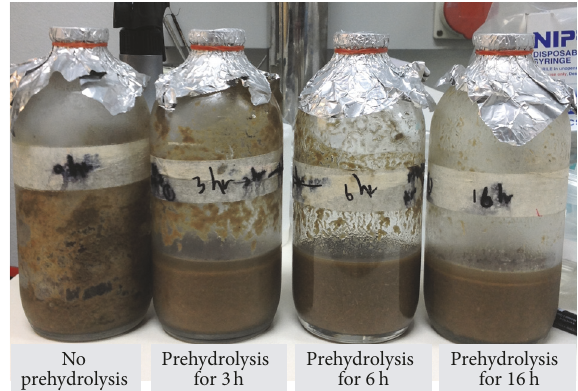
Figure 7: Appearance of 10% (w/v) aRS loadings without/with prehydrolysis at 3, 6, and